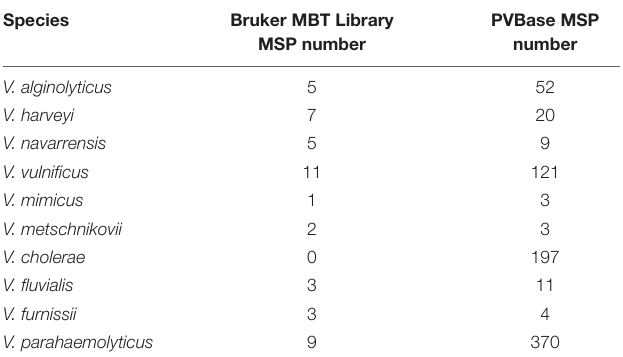
TABLE 1 | Numbers of main spectra projections (MSP) for the Vibrio species that are potentially pathogenic in the Bruker MBT Library and in our